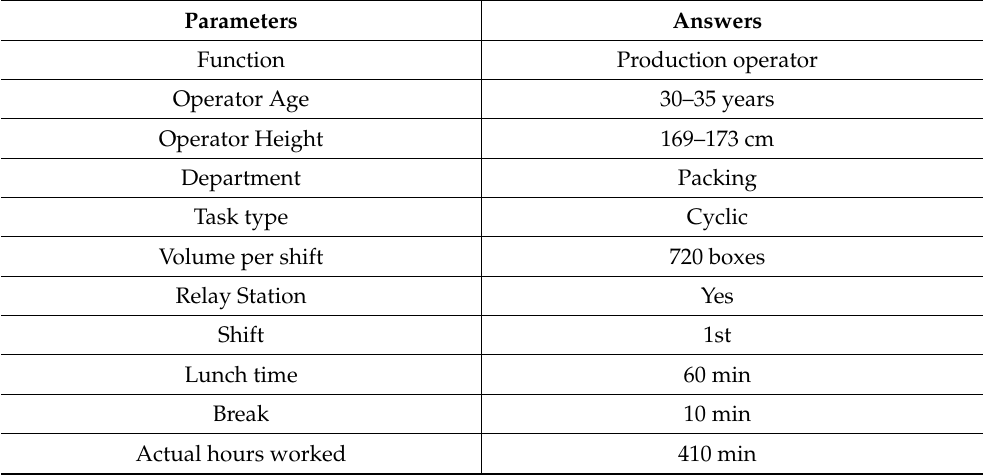
Table 3. Characterization parameters of the job and